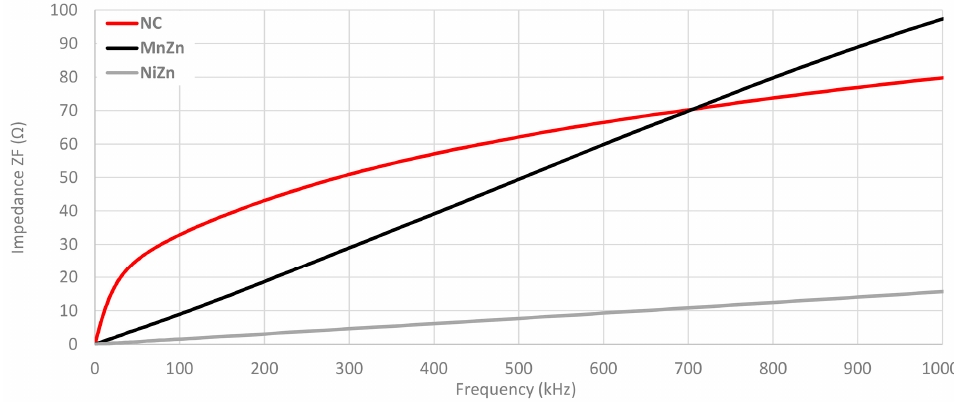
Figure 10. Impedance comparison of the three cable ferrites measured with 1 turn.